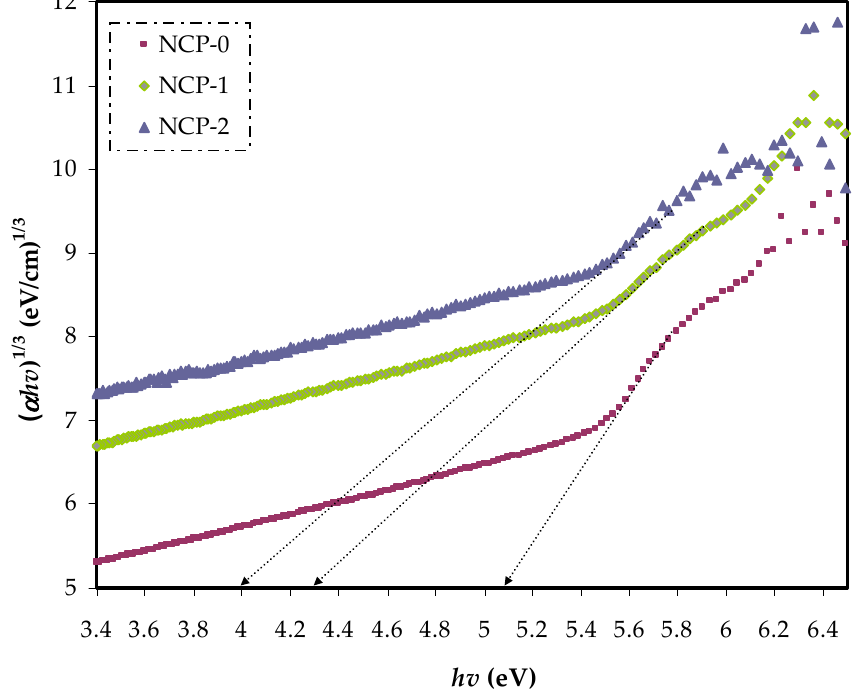
Figure 11. ( α h υ ) 1/3 v photon energy for NCP-0 and composite samples.